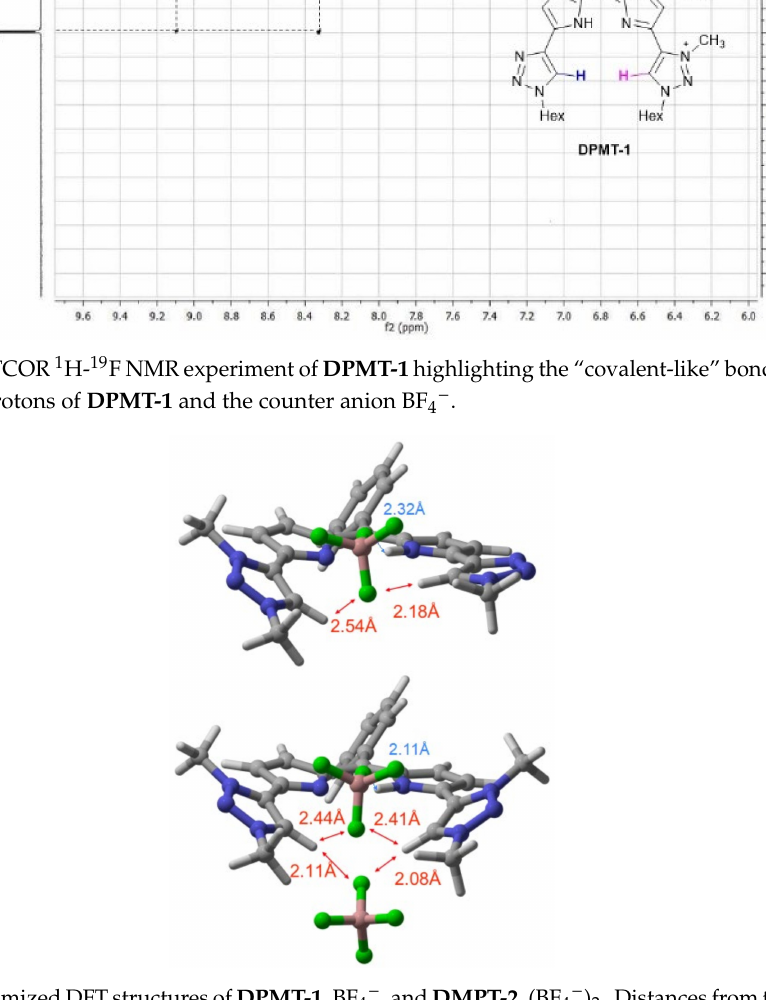
Figure 5. Optimized DFT structures of DPMT-1 , BF 4 − , and DMPT-2 , (BF 4 − ) 2 . Distances from the closest F of BF 4 − to the pyrrole NH are shown in blue and to the triazolium CH in red. − The next step was dedicated to the determination of the association constant of BF 4 to the ligand. − Two new ligands DPMT-3 and DPMT-4 , displaying B(C 6 F 5 ) as the non-coordinating counter anion, were obtained using an appropriately conditioned ion-exchange resin (Scheme 3). NMR titrations − were performed using TBABF 4 and revealed association constants for BF 4 of 1300 ( DPMT-3 ) and 2000 − ( DPMT-4 ). These values are relatively important for the binding of an anion such as BF 4 and justify the lower K observed for DPMT-2 than DPMT-1 . Hence, the real association constants K” 1 and K” 2 , − relative to the binding of the anions X to DPMT-1 and DPMT-2 , respectively, were calculated according to the formula: K” = K × K’ (Table